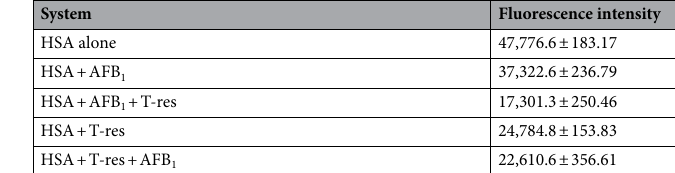
Table 4. The effect of AFB 1 and trans- resveratrol on the fluorescence intensity of HSA at λex = 280 nm, T = 298.15 K, and pH = 7.4. The concentration of HSA alone was taken as 5 µM and the concentration of T-res = AFB 1 = 14